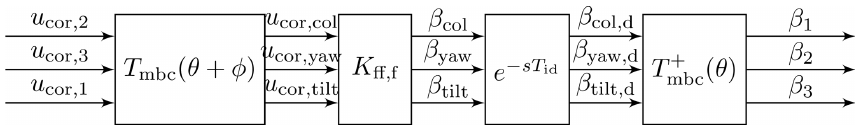
) is applied to the outputs. mbc